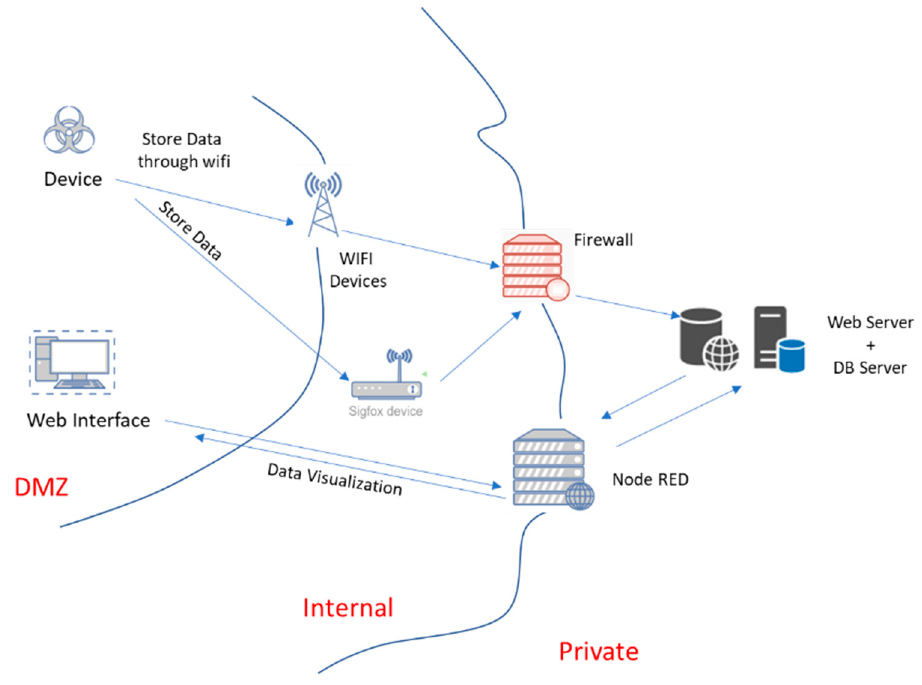
Figure 6. Thread model of the radon monitoring system.